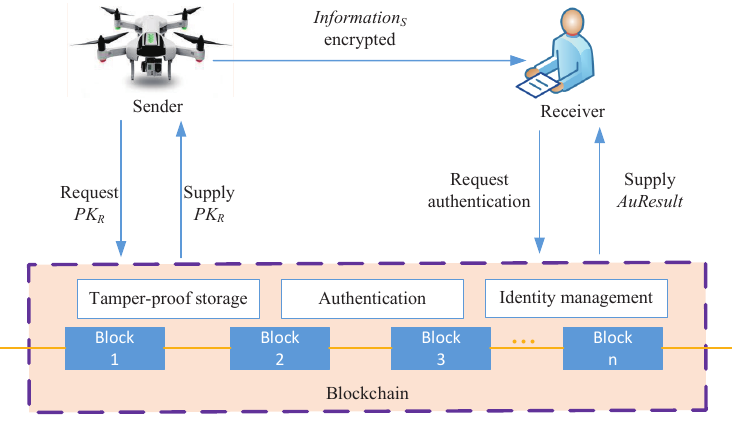
Figure 3. Secure communication architecture based on